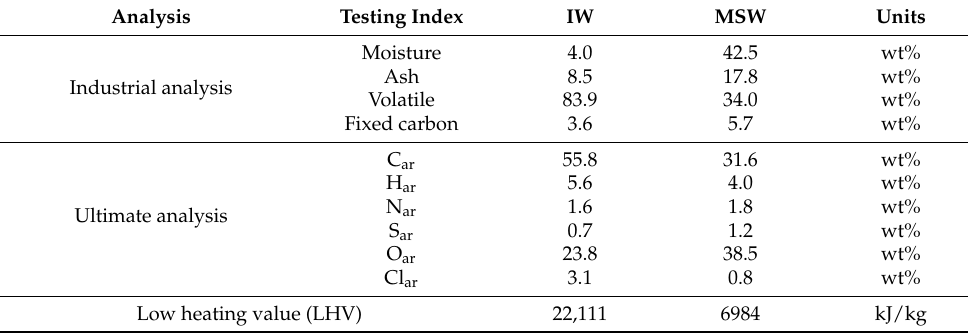
Table 1. Composition (mean value) of MSW and IW in the